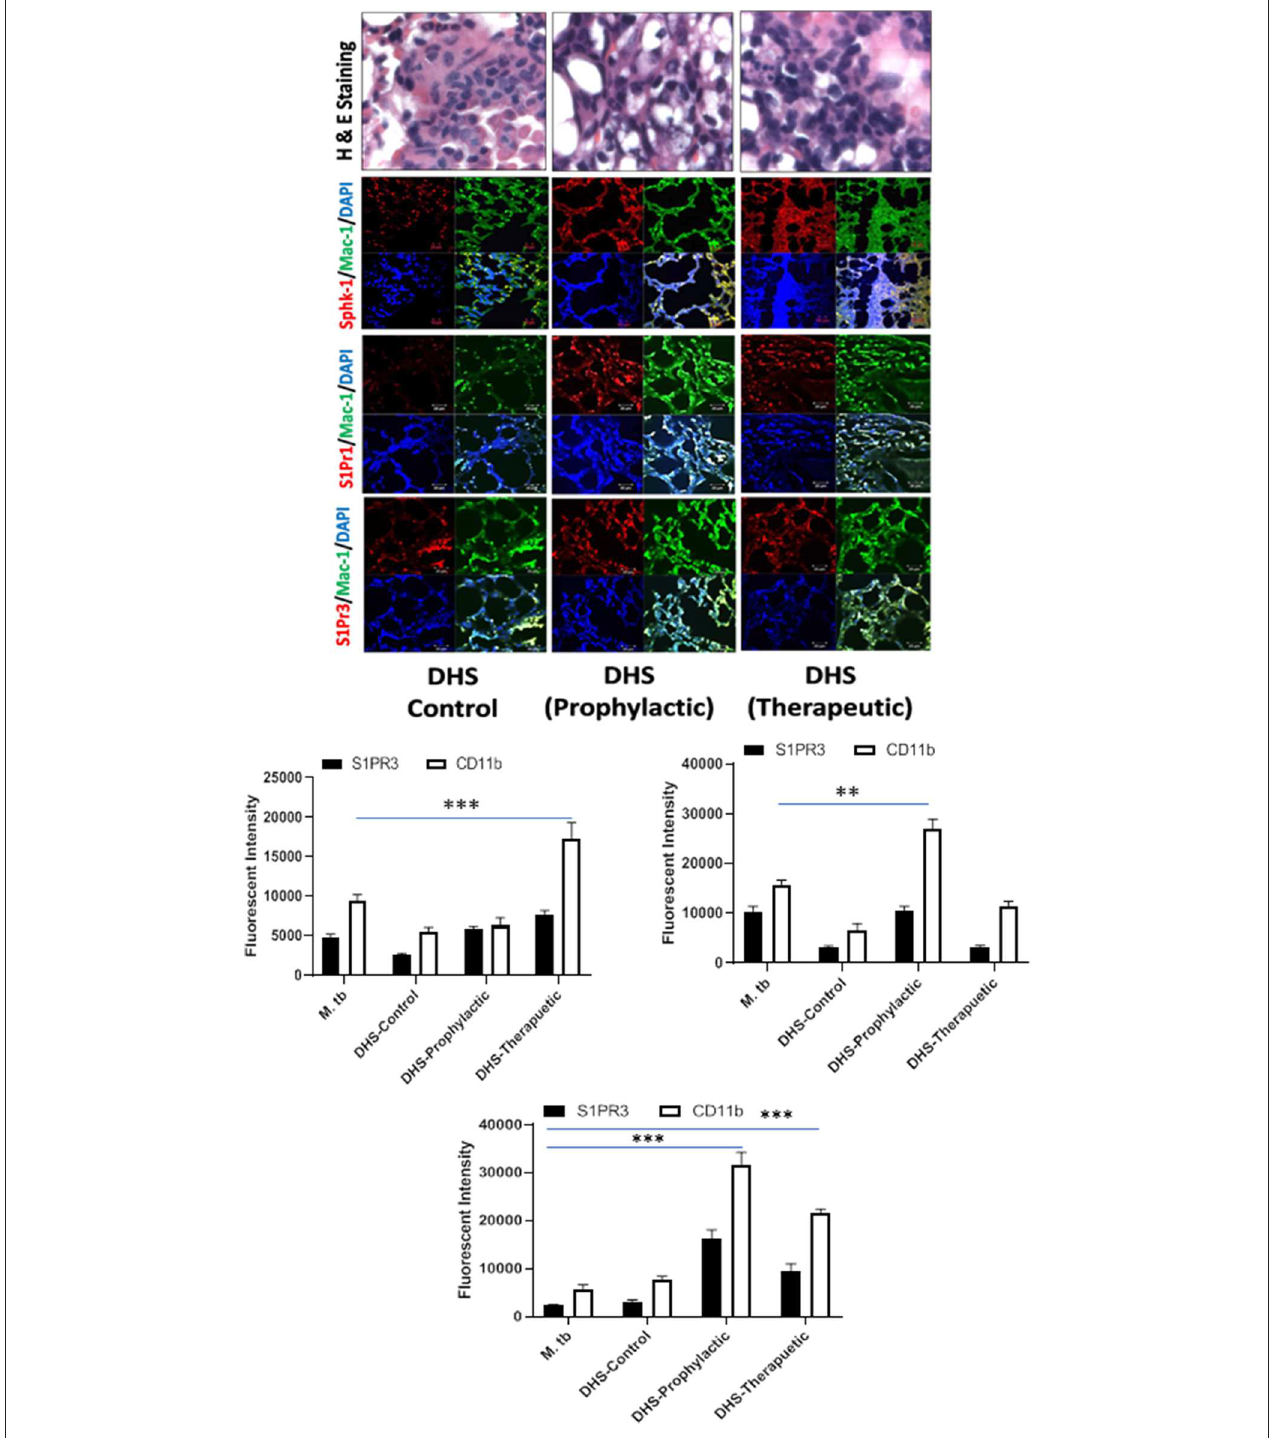
FIGURE 8 | DHS failed to control M. tuberculosis burden due to reduced SphK-1 activity. The infected mice were treated with DHS as per Figure 3A , and cryosections of lungs from these mice were analyzed for expression of sphingosine-1-phosphate receptor (S-1PR)1, S-1PR3, and SphK-1 and infiltration of CD11b + macrophages by confocal microscopy. Shown here is the representative images of mouse lung from each group. Mean fluorescence intensities of Sphk-1, S-1PR1, and S-1PR3 expression were plotted against Mac1 expression. Statistical analyses were conducted using two-way ANOVA followed by Bonferroni posttest (** P < 0.01, *** P <